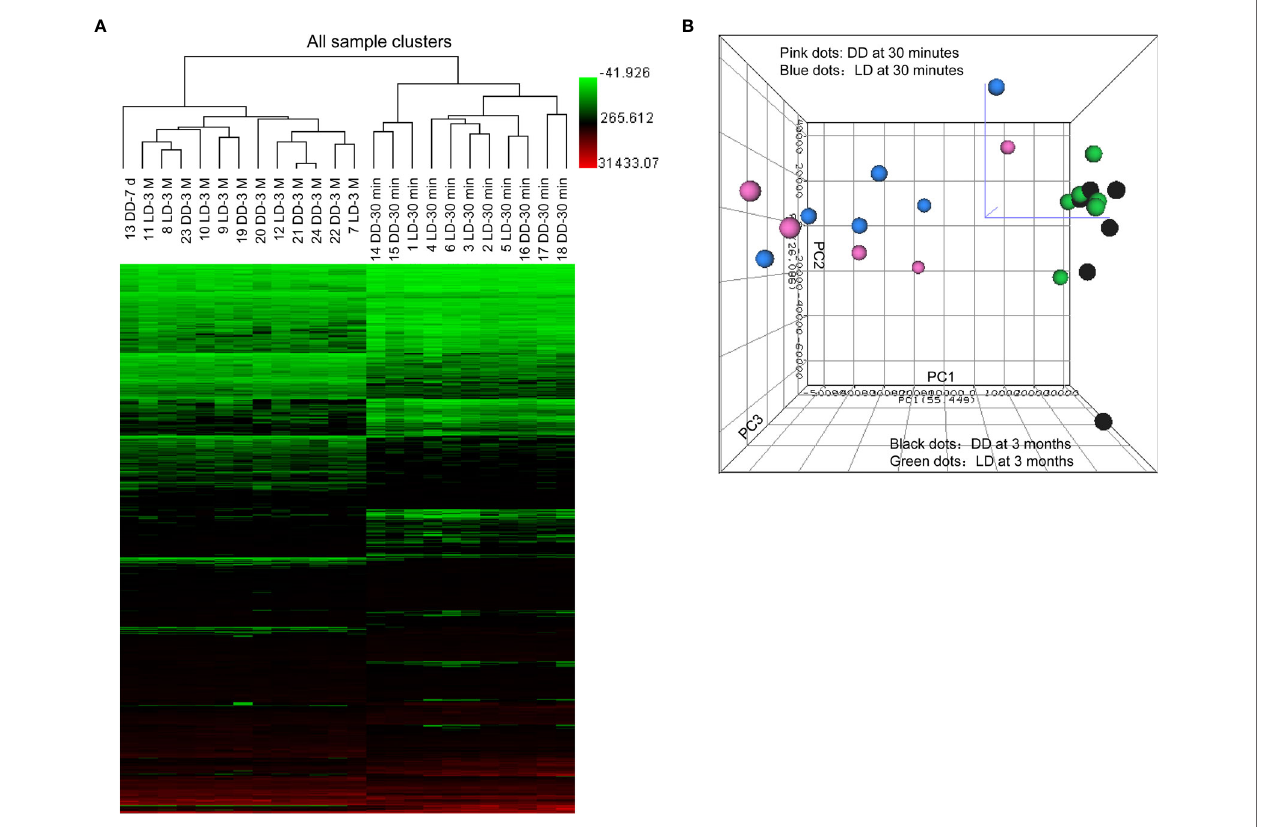
FIGURE 2 | Heat map of raw data analysis of microarray, unsupervised hierarchical clustering and principal component analysis. (A) 899 signi fi cant DEGs (P < 0.05 and FC > 1.5) in 24 microarray analyzed samples were included in the heat map for unsupervised hierarchical clustering analysis illustrated as Euclidean + Average of non-normalized data. (B) Samples from biopsies at 30 minutes (dots in pink for DD and blue for LD) and 3 months (dots in black for DD and green for LD) were located into two clearly separated areas demonstrating clear differences in the overall gene pro fi le between two different time points post-transplantation, rather than two donor types, expect one day 7 sample. The bigger was the dot size, the closer was the dot to the reader.